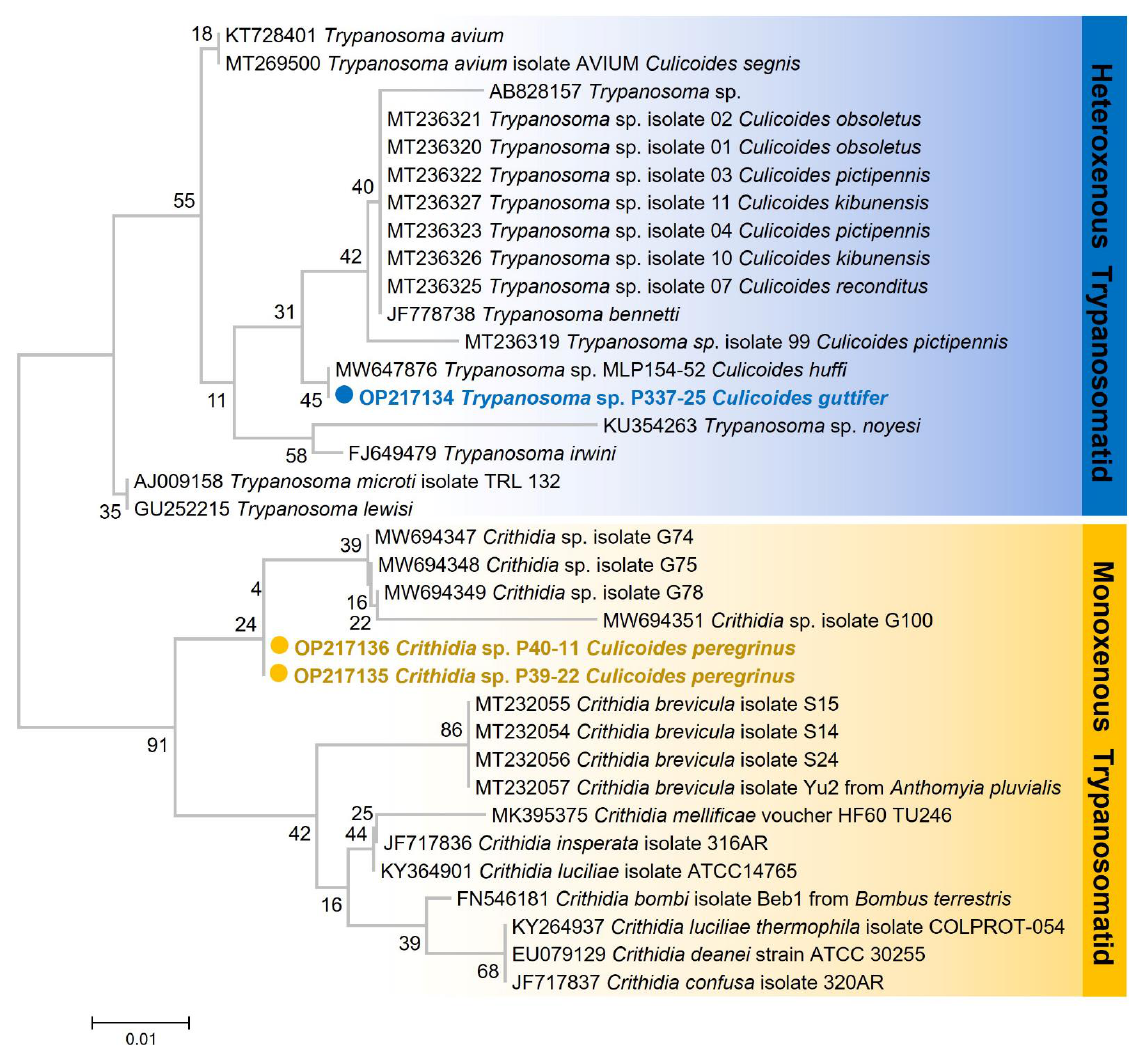
Figure 6. Phylogenetic tree based on partial SSU rRNA sequences of Trypanosomatids including Trypanosoma and Crithidia parasites. The tree was constructed using the maximum likelihood method with the K2+G model, generated by the 1000 bootstrap tests. For haemosporidian detection, nPCR based on the haemosporidian cytb gene was positively detected in four (0.82%) specimens. Leucocytozoon sp. was found in three